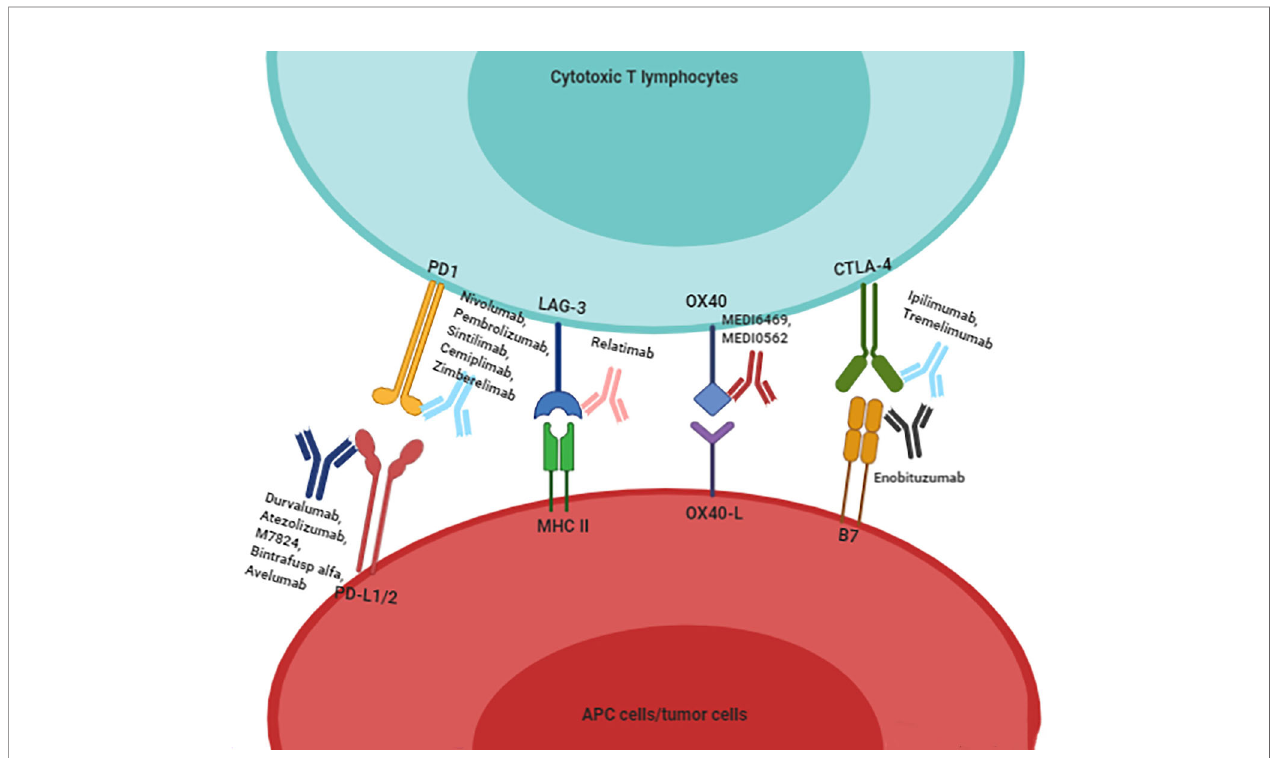
FIGURE 2 | To summarize the existing immune checkpoint inhibitors for HNSCC patients. Immunotherapy drugs combine with immune checkpoints to block the inhibitory effect of immune checkpoints on cytotoxic T lymphocytes, and then activate the proliferation and in fi ltration of T cells.